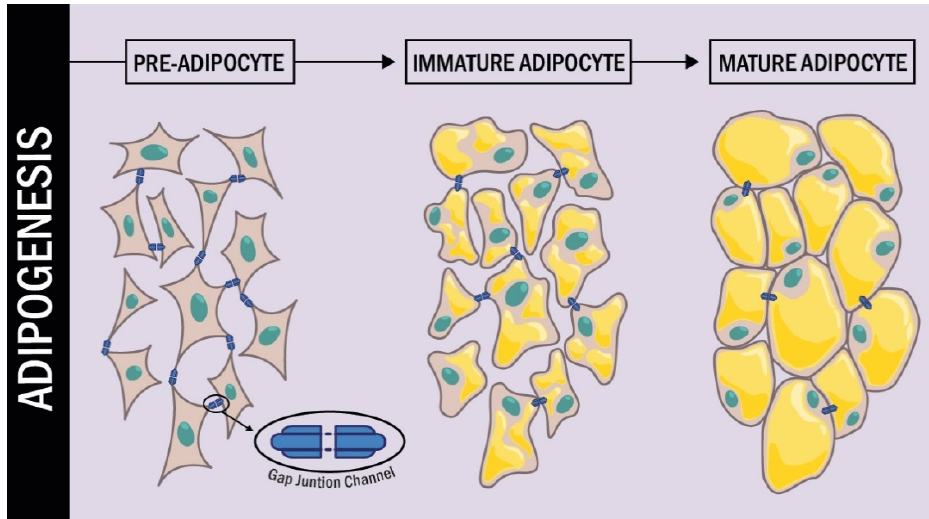
Figure 2. Cx43 expression during adipogenesis. During the process of differentiation from pre-adipocytes to mature adipocytes, the connexins undergo changes in their expression. Initially in a mesenchymal cell, the expression of Cx43 is high, but as differentiation occurs the expression levels of Cx43 decrease dramatically.